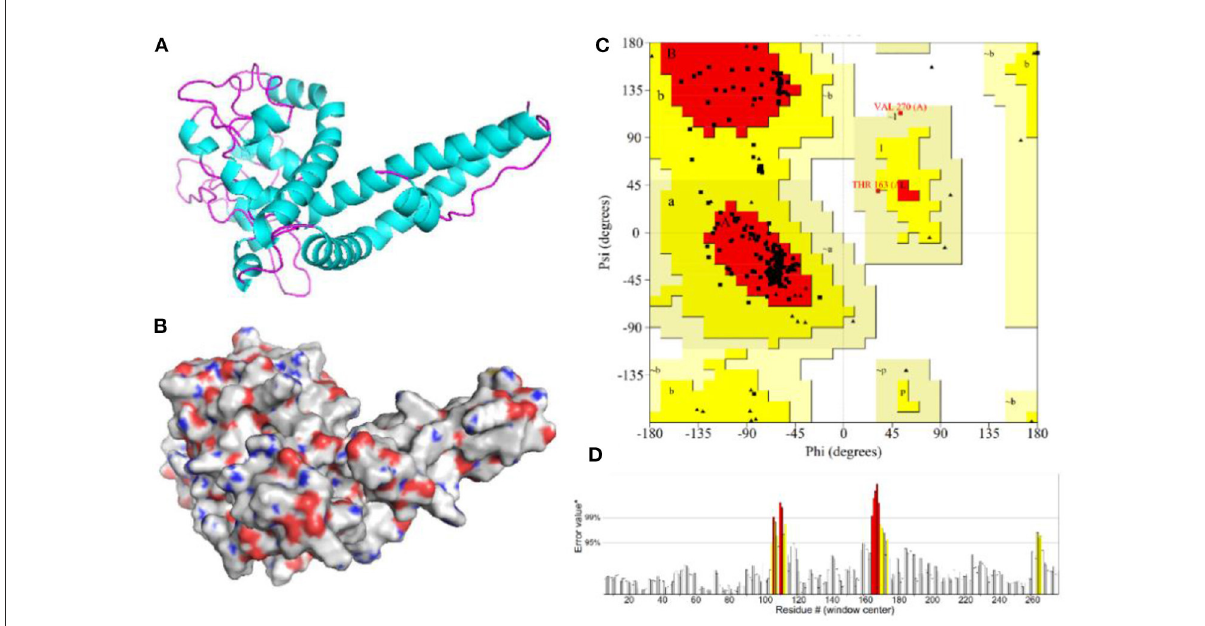
FIGURE6 Homology modeling and validation of the three-dimensional structure of vaccine constructs. (A,B) 3D models of vaccine constructs generated by homology modeling on Robetta and visualized by PyMOL software. (C) Ramachandran plot analysis shows 100% of residues in the allowed region. (D) The overall quality factor score for the model was 92.647%.